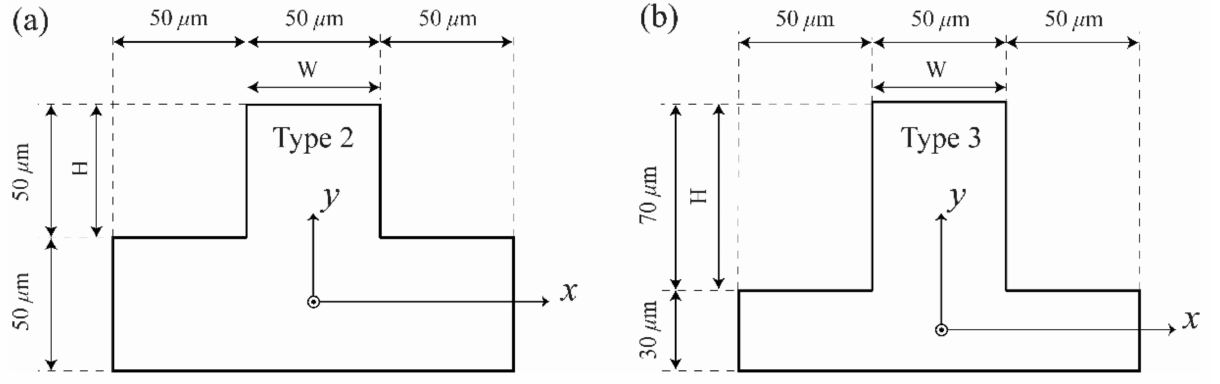
Figure 2. Cross-sectional shape and dimensions of ( a ) Type 2 and ( b ) Type 3 microchannel considered in the numerical simulation. x and y on a cross-plane represent a horizontal and a vertical axis in the Cartesian coordinate system considered in the numerical